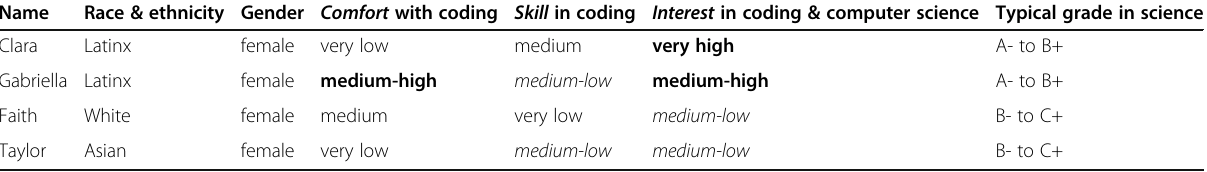
Table 7 Background information for two student-teams (Clara & Gabriella; Faith & Taylor)